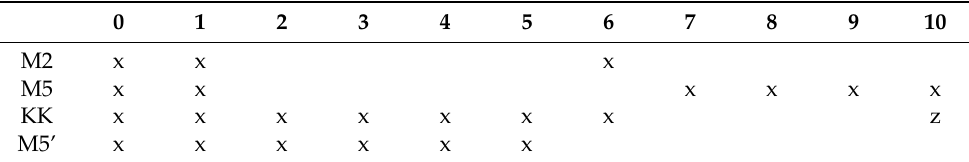
Table 2. 1 -BPS brane intersection underlying the AdS 3 × S 3 / Z k solutions in M-theory. The 2D 8 CFT lives in the ( x 0 , x 1 ) directions, ( x 2 , . . . , x 5 ) span the CY 2 , x 6 is the “field theory” direction and